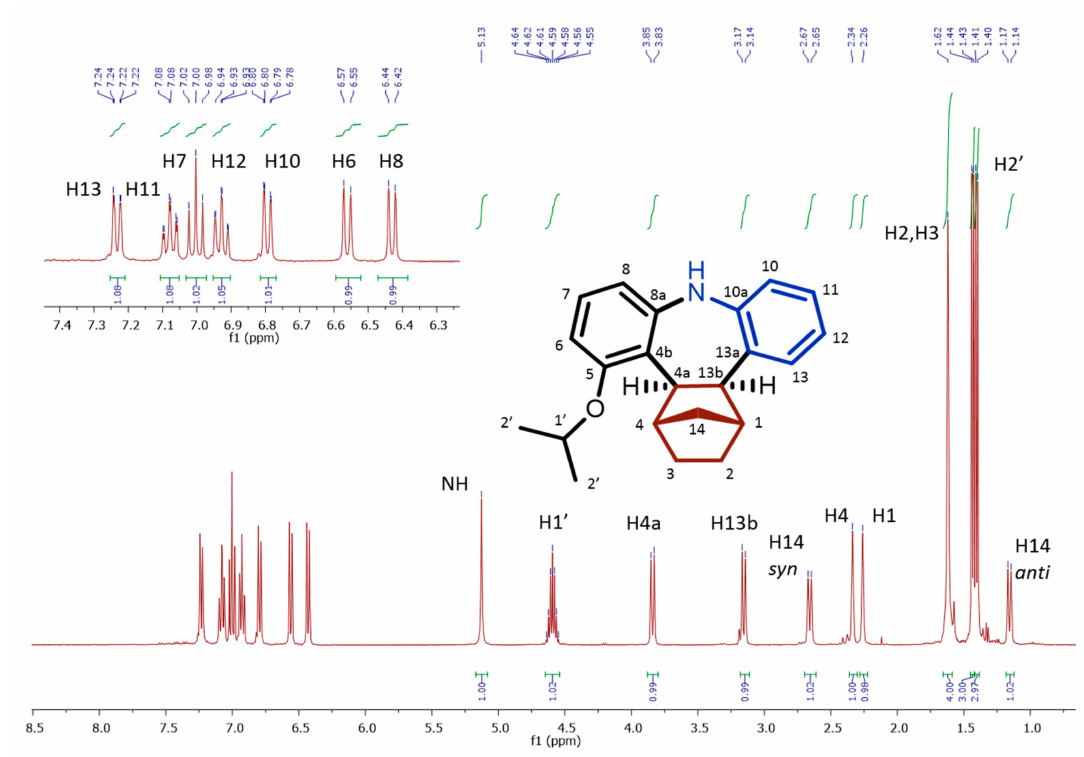
Figure 1. 1 H-NMR spectrum of compound 3 (CDCl 3 , 400 MHz) and related assignment.